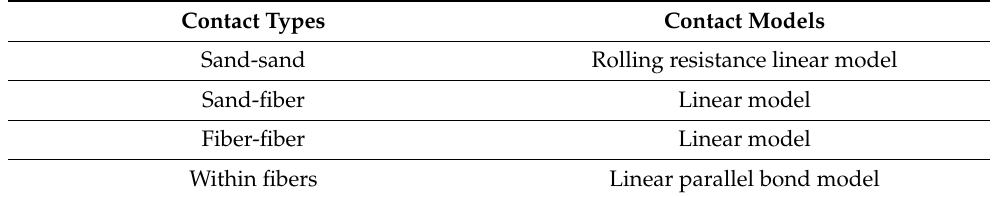
Figure 3. Contact types in the DEM model of fiber-reinforced sand. Table 1. Contacts model selection of DEM